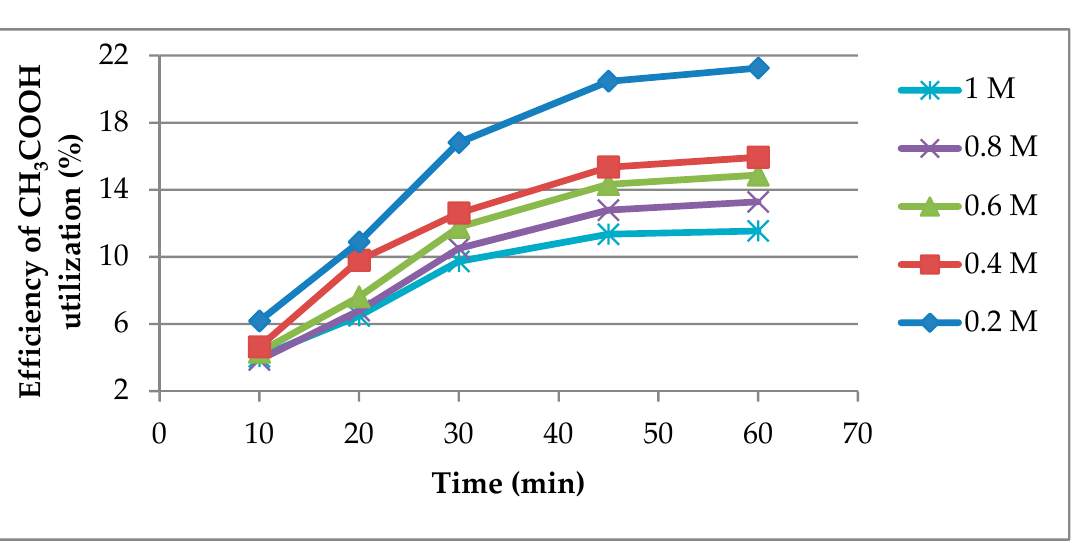
Figure 1. Dissolution degree vs. time at different CH 3 COOH concentrations. In addition to increasing the dissolution degree with increasing CH 3 COOH concentra- tion, it is important to increase the conversion of the leaching agent in order to exploit the full potential of the leaching solution. To highlight this aspect, the efficiency of CH 3 COOH utilization was determined, which indicates how much of the leaching agent was converted under different experimental conditions compared to what could theoretically be used for lead dissolution, taking into account the initial amount of CH 3 COOH in the solution. The results from Figure 2 show that the efficiency of CH 3 COOH utilization is diminished by increasing the concentration of CH 3 COOH, the maximum value being reached at a concentration of 0.2 M acetic acid.